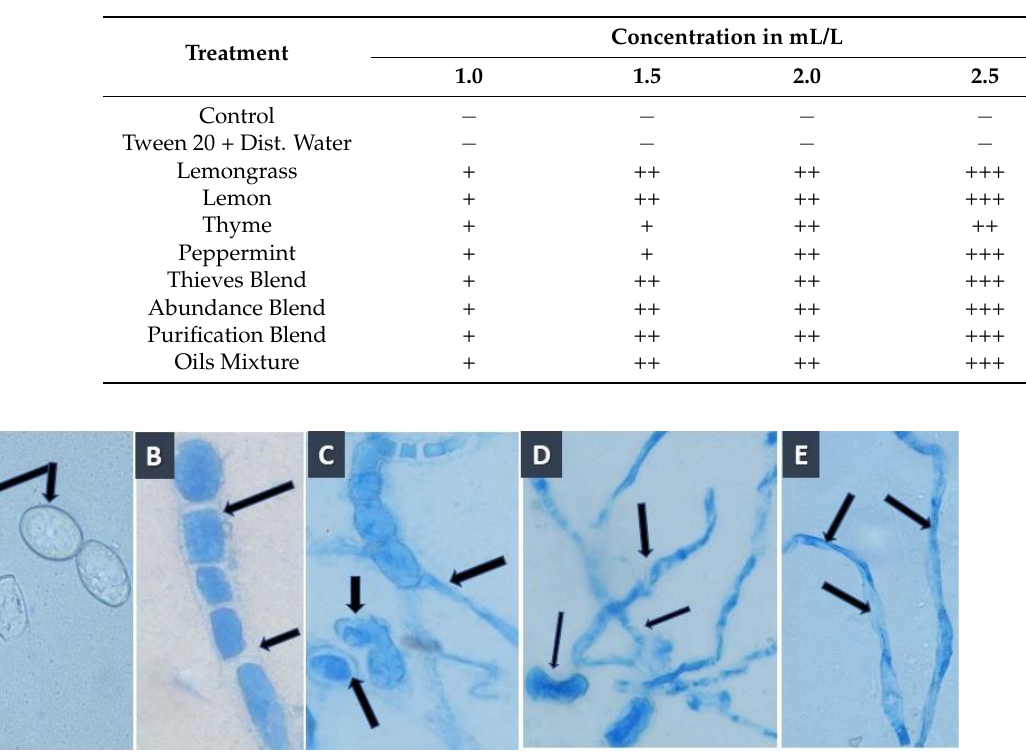
Table 2. In vitro fungitoxic effects of the essential oils on the morphology of the mycelia and conidia of Podosphaera xanthii .